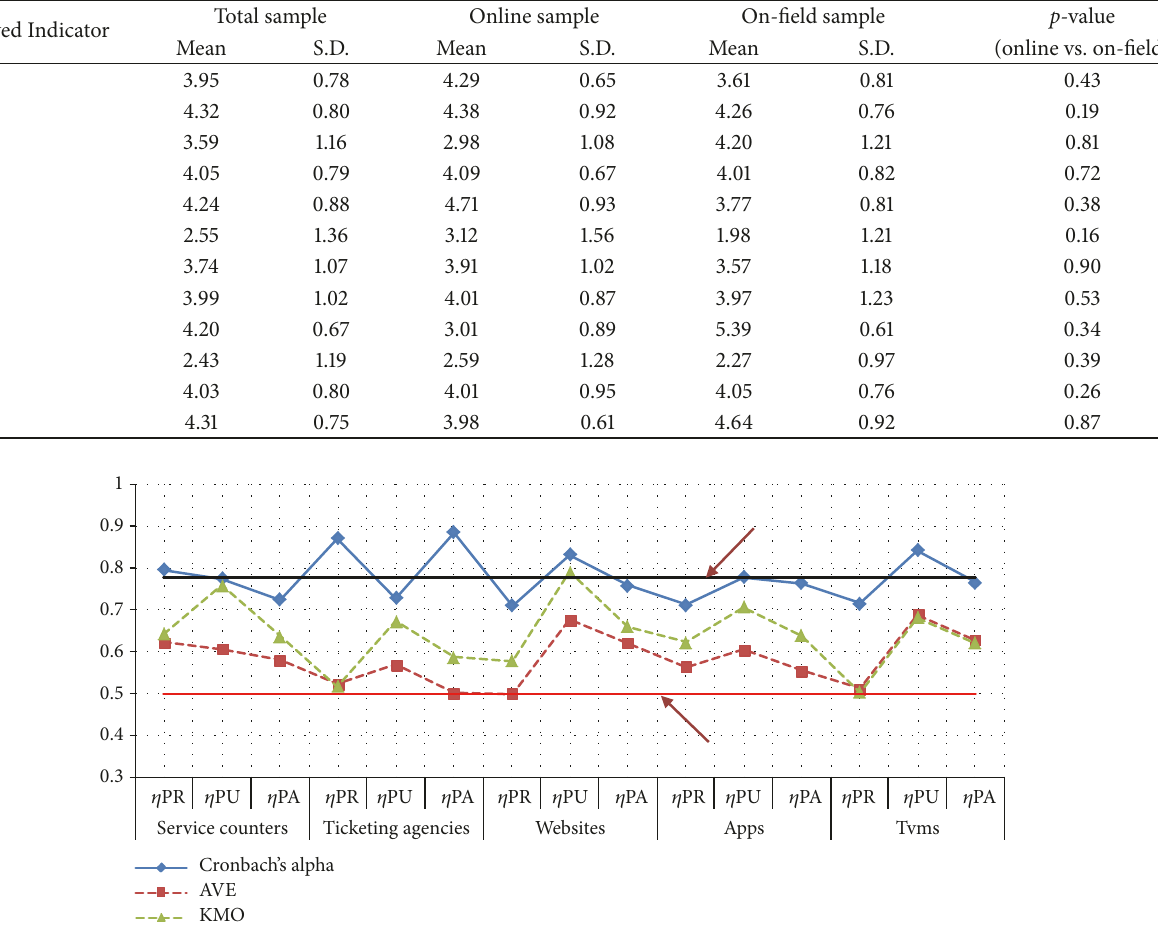
Table 3: Scores of the measurement items for perceptions.